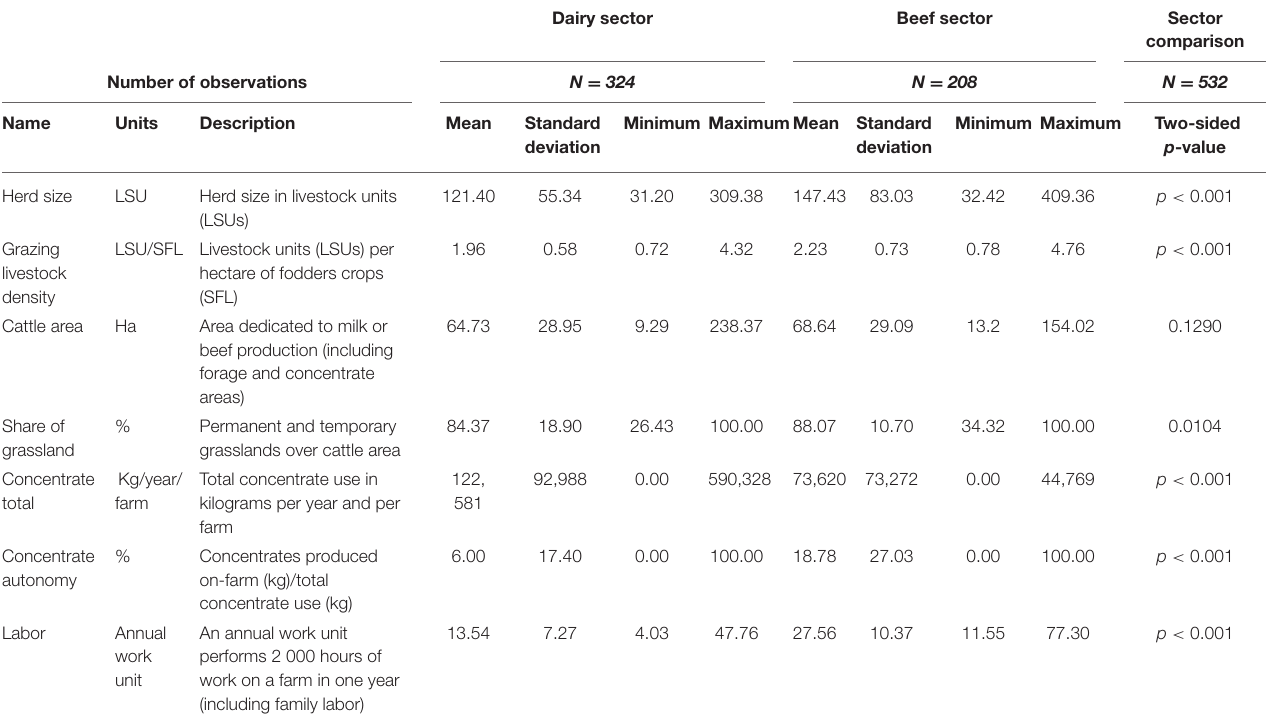
TABLE 2 | Summary statistics of independent